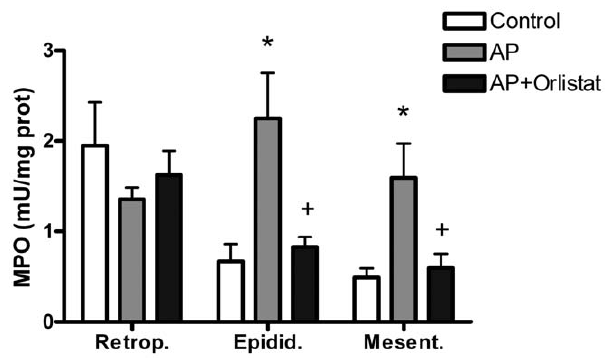
Figure 3. Inflammation in different areas of white adipose tissue was evaluated by measuring myeloperoxidase (MPO) activity. Pancreatitis (AP) results in the induction of MPO activity in epididymal and mesenteric adipose tissue. Lipase inhibition with Orlistat abolished these increases. By contrast, no significant changes were observed in the retroperitoneal adipose tissue. * = p , 0.05 vs control; + = p , 0.05 vs